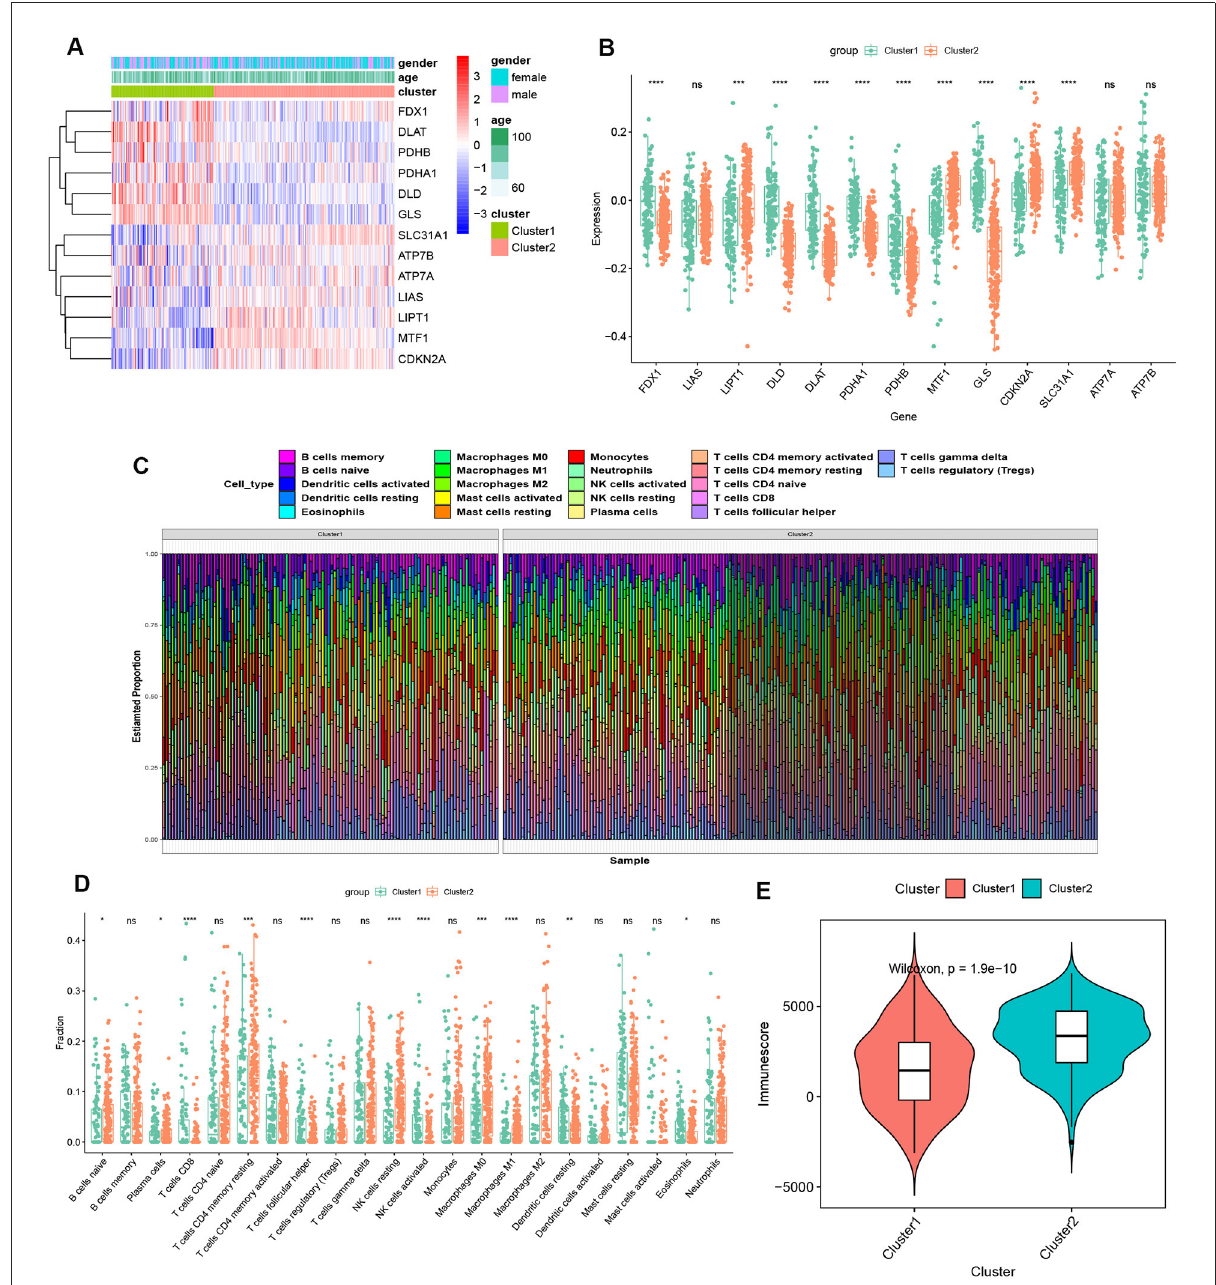
FIGURE4 Identification of molecular and immune characteristics between the two cuproptosis clusters. (A) Clinical features and expression patterns of 13 CRGs between two cuproptosis clusters were presented in the heatmap. (B) Boxplots showed the expression of 13 CRGs between two cuproptosis clusters. *** p < 0.001, **** p < 0.0001, ns, no significance. (C) the relative abundances of 22 infiltrated immune cells between two cuproptosis clusters. (D) Boxplots showed the differences in immune infiltrating between two cuproptosis clusters. * p < 0.05, ** p < 0.01 *** p < 0.001, **** p < 0.0001, ns, no significance. (E) Boxplots showed the estimated immune score between the two cuproptosis